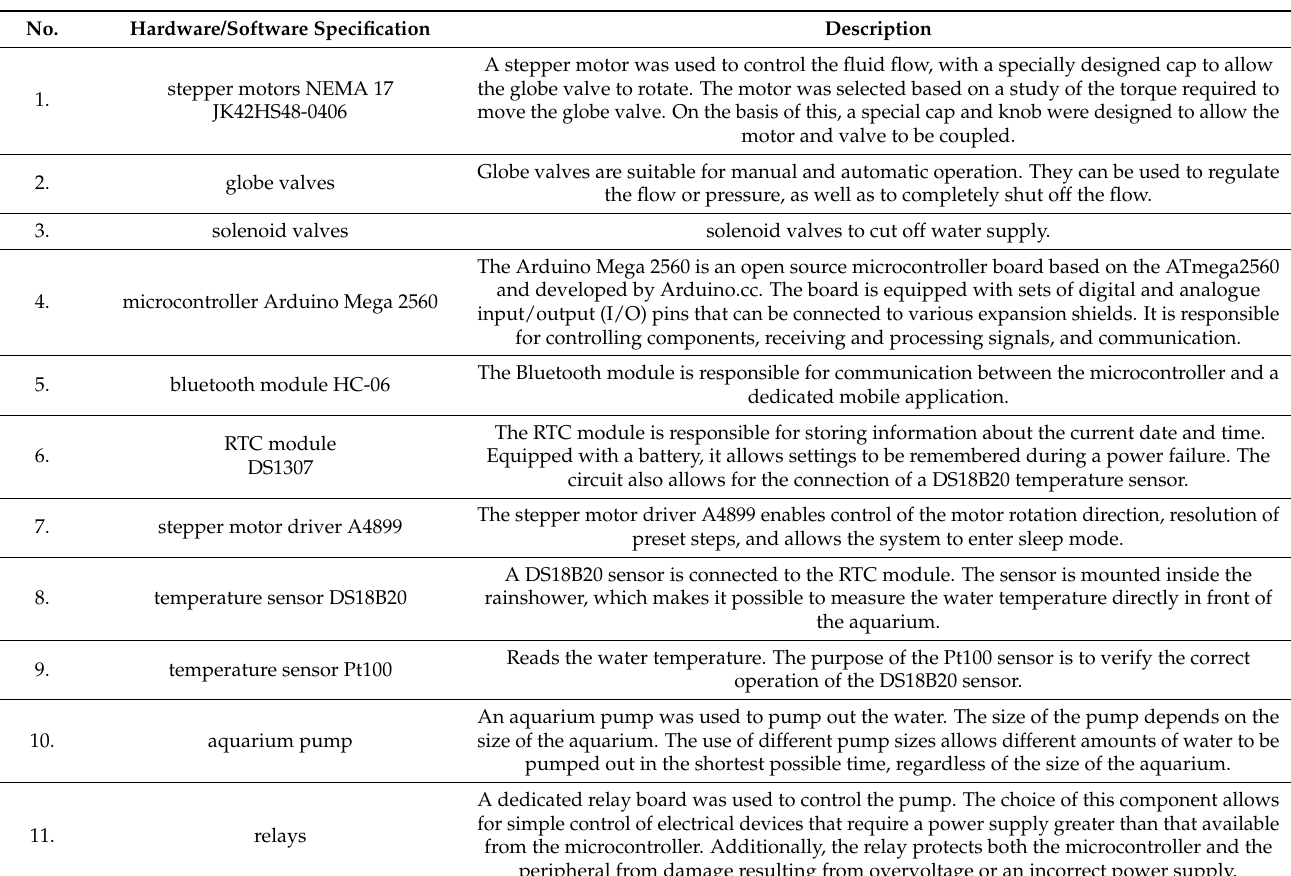
Table 5. List of components used for the AWES prototype. The additional parts of the AWES system, such as a knob, a cap, clutches, or handles, are not detailed